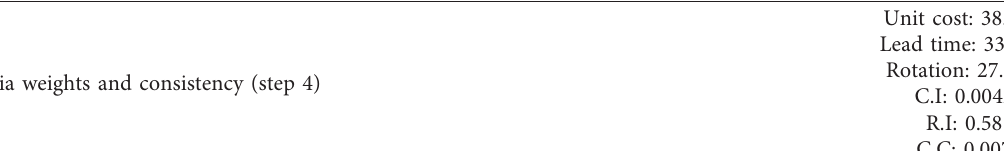
Table 9: Application of step 4 of the methodology (AHP method results).